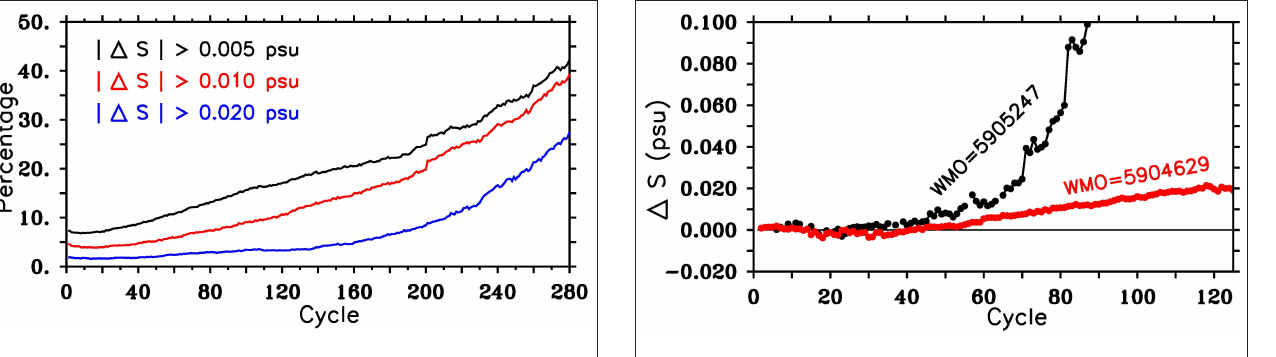
float salinity data with about 0.01 PSS-78 uncertainty. In most